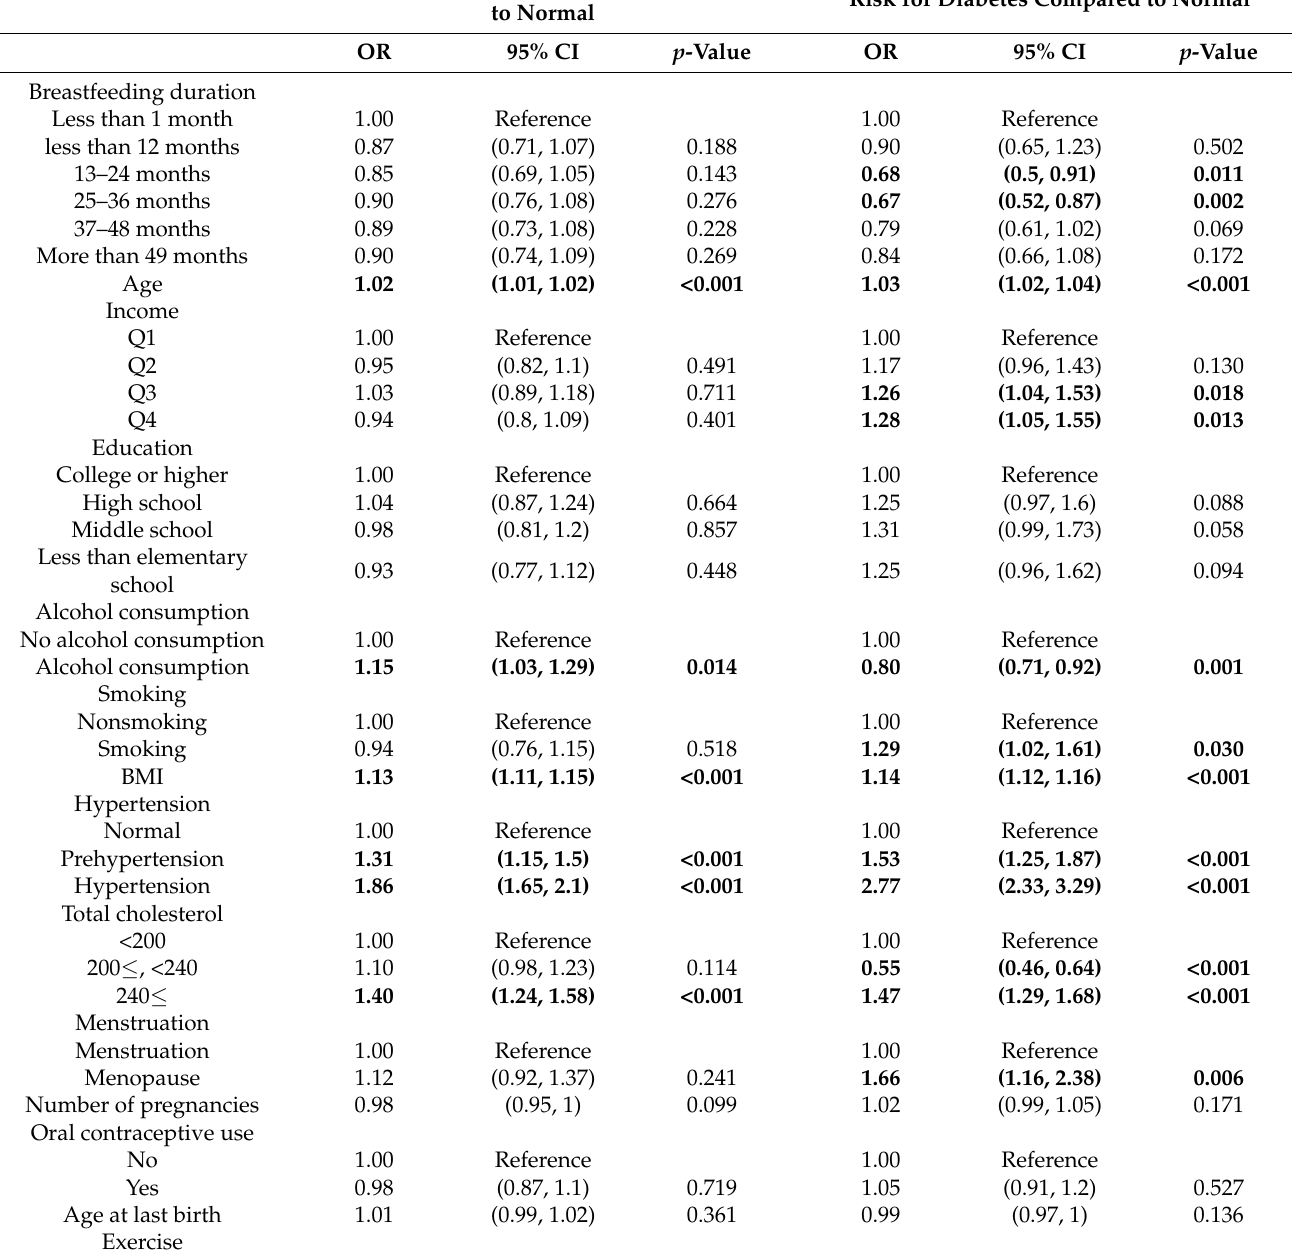
Table 4. Multivariate logistic regression analysis results of risk for impaired fasting glucose and diabetes according to breastfeeding duration. Risk for Impaired Fasting Glucose Compared Risk for Diabetes Compared to to Normal